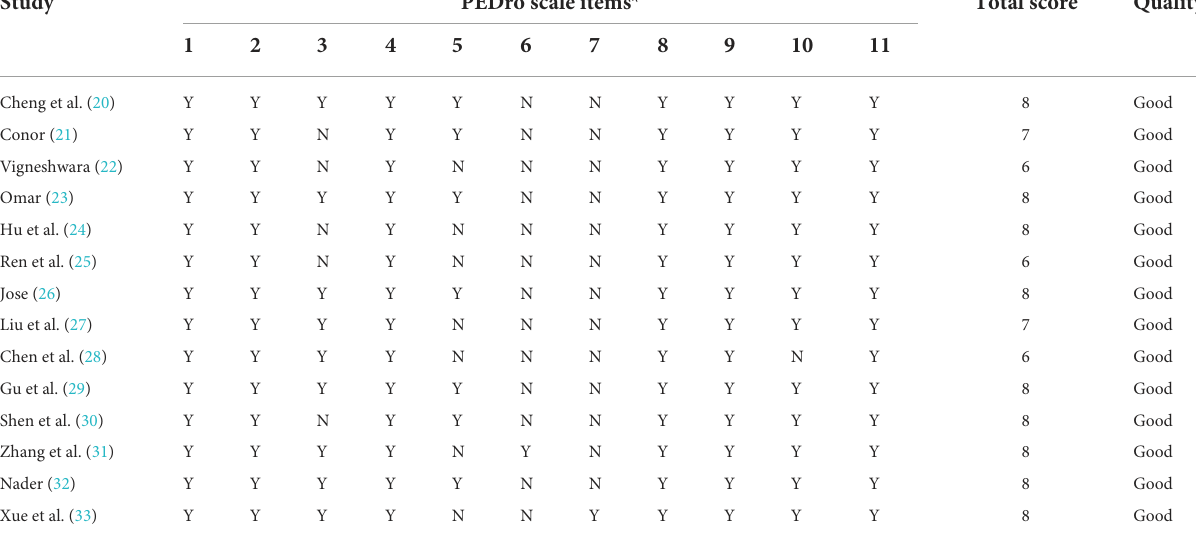
TABLE 3 Assessment of the methodological quality using the PEDro scale.